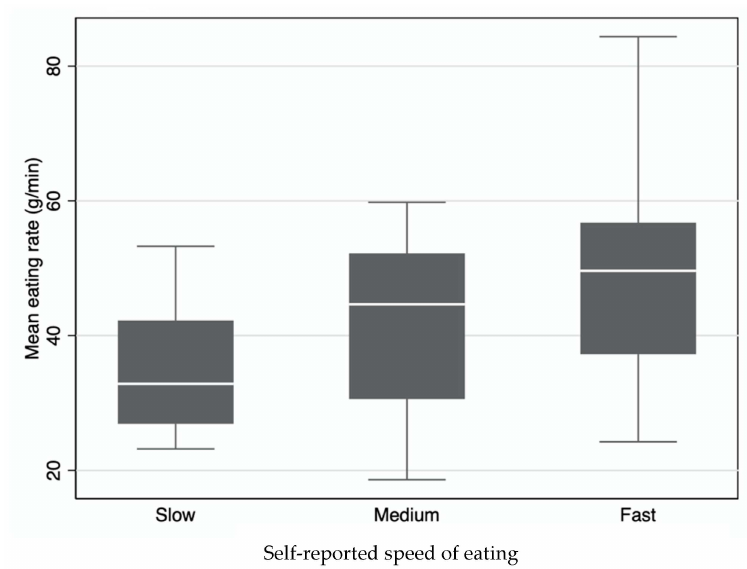
Figure 1. The medians (horizontal white lines) of the mean eating rate (g / min) among the self-classified speed of eating categories. The box represents the interquartile range (25 th to 75 th percentiles) and the whiskers give the full range of the mean eating rate.